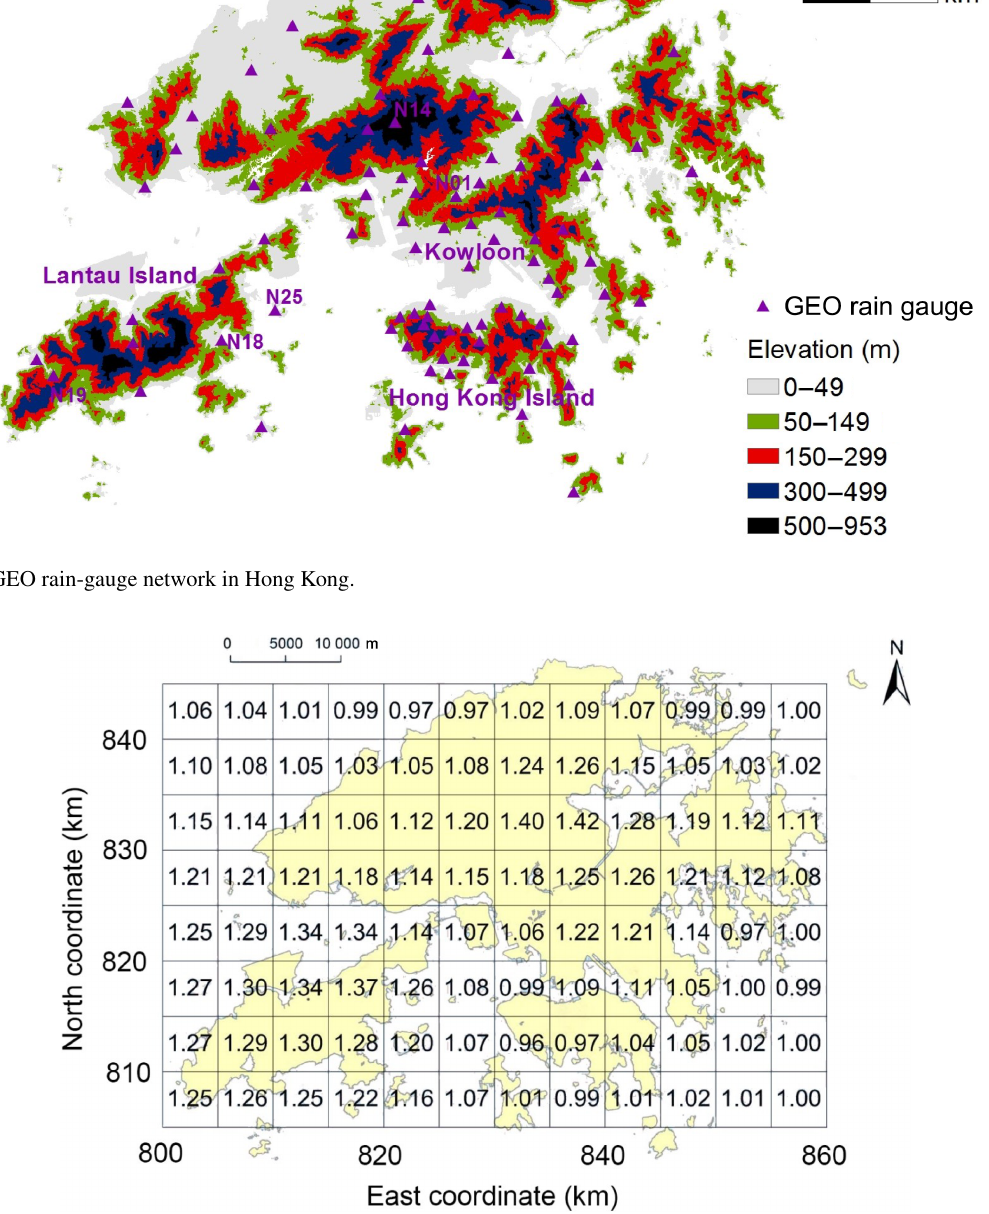
Figure 4. The 24h orographic intensification factors in Hong Kong (modified from AECOM and Lin,